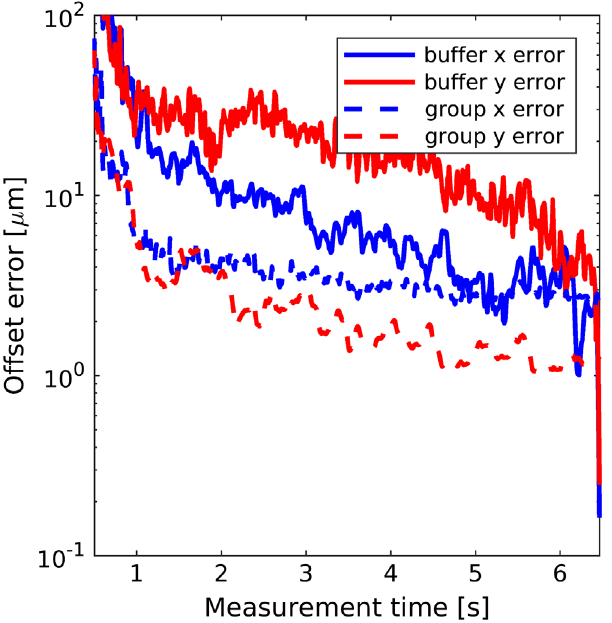
FIG. 12. Measured average of 5 BPM offset errors as a function of the acquisition time for a ac skew quadrupole FBBA.